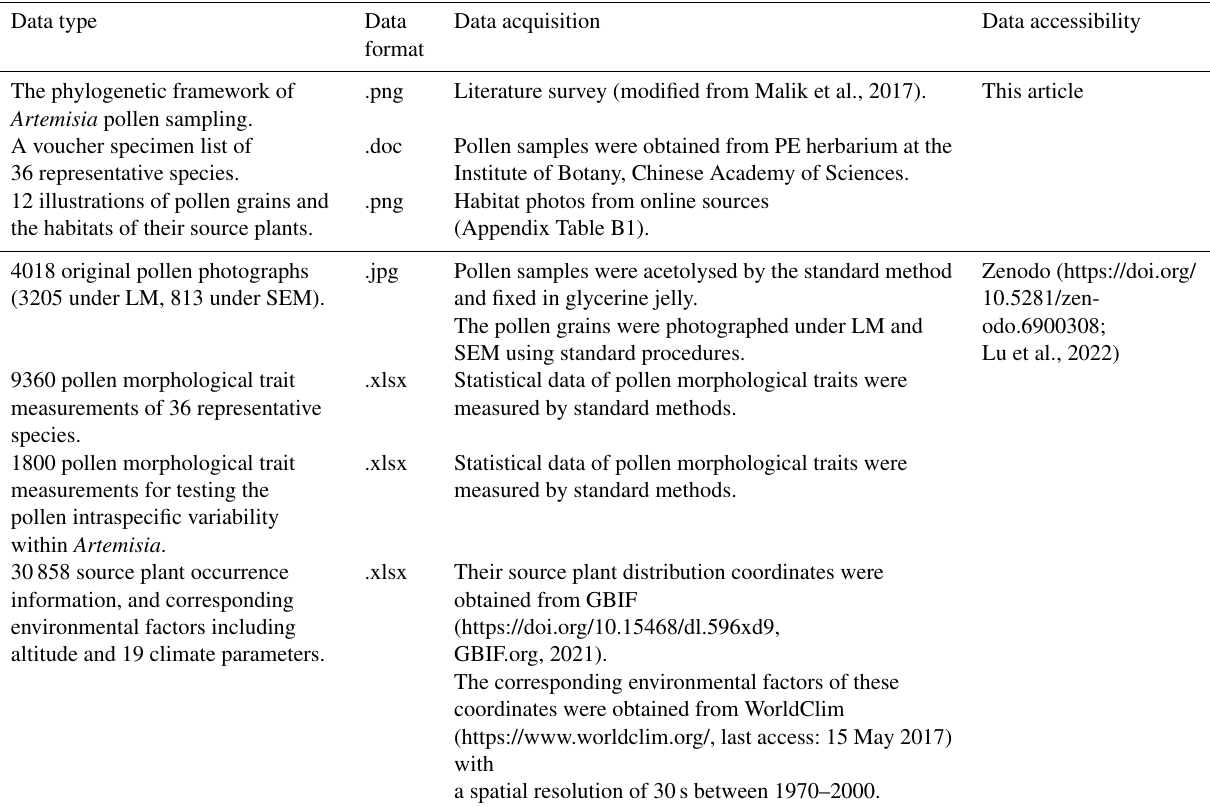
Table 3. Artemisia pollen datasets in this